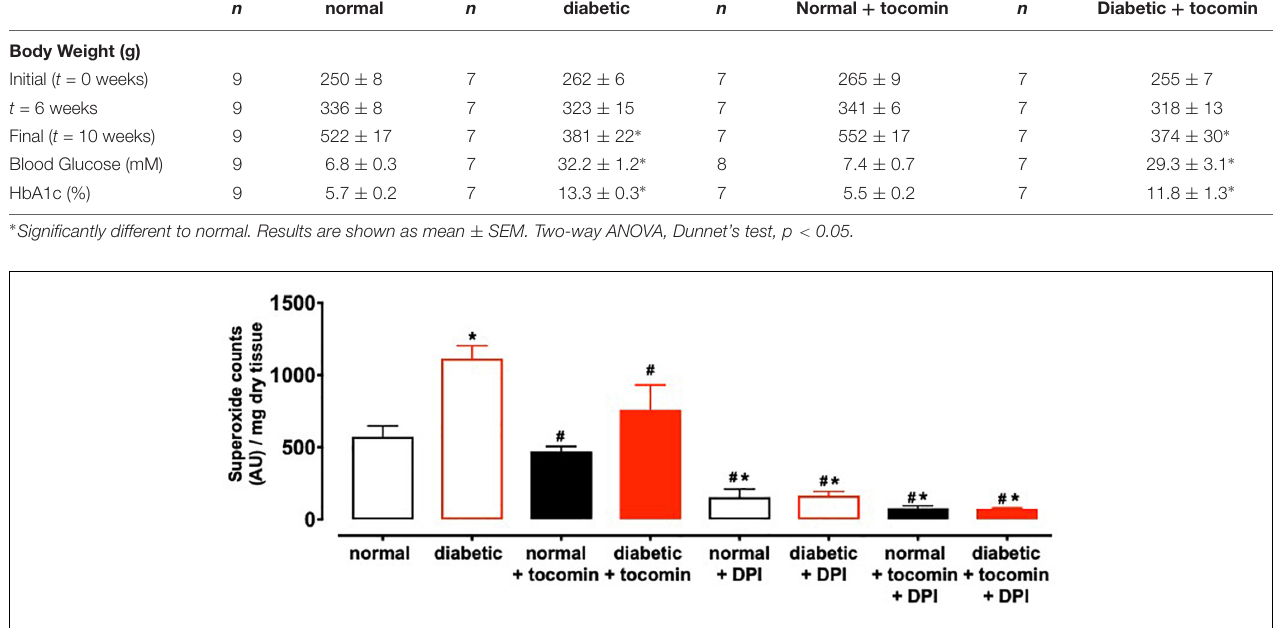
FIGURE 1 | Superoxide generated in rat aorta in the presence of NADPH from normal, diabetic, and tocomin treated (normal + tocomin/diabetic + tocomin) and in the presence of DPI. Data is expressed as mean ± SEM. ∗ Significantly different to normal. # Significantly different to diabetic. Results are shown as mean ± SEM.